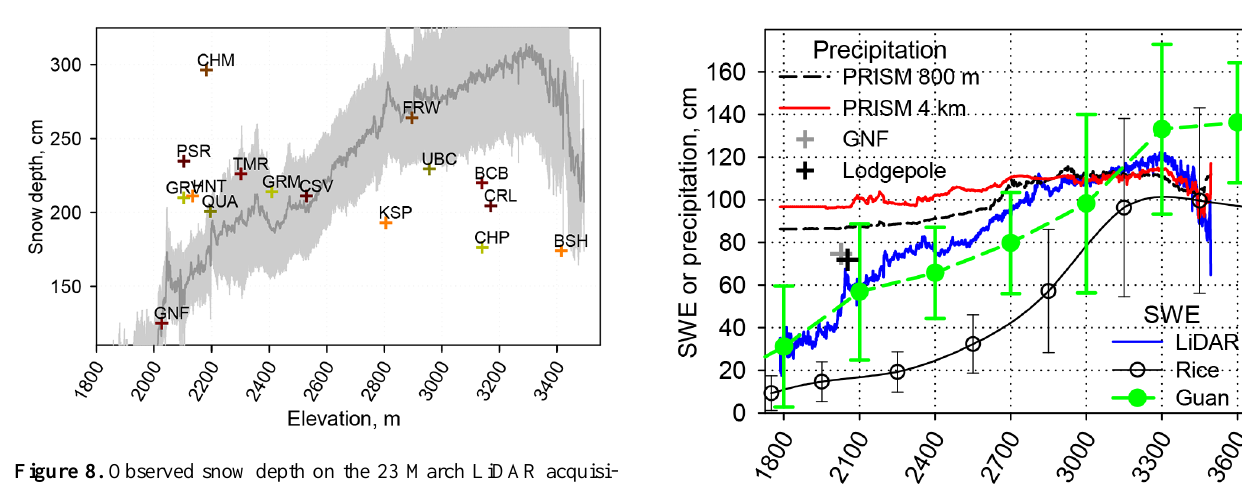
(data available at http://cdec.water.ca.gov/, 2014) (Fig. 1). When compared with the LiDAR SWE estimates in Fig. 9, both stations show slightly more precipitation.